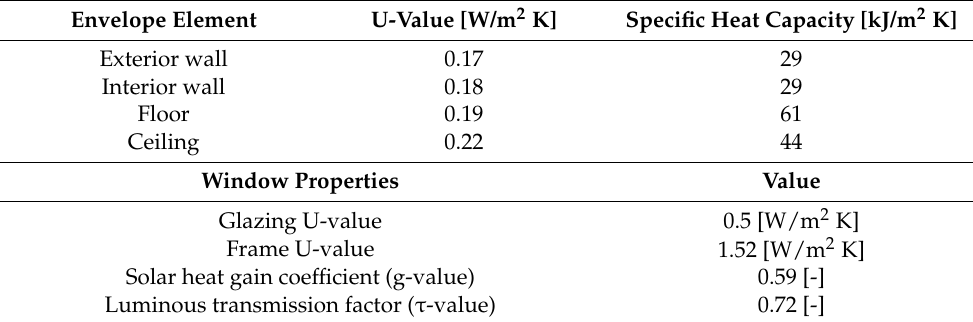
Table 3. Thermo-physical characteristics of the SolAce unit